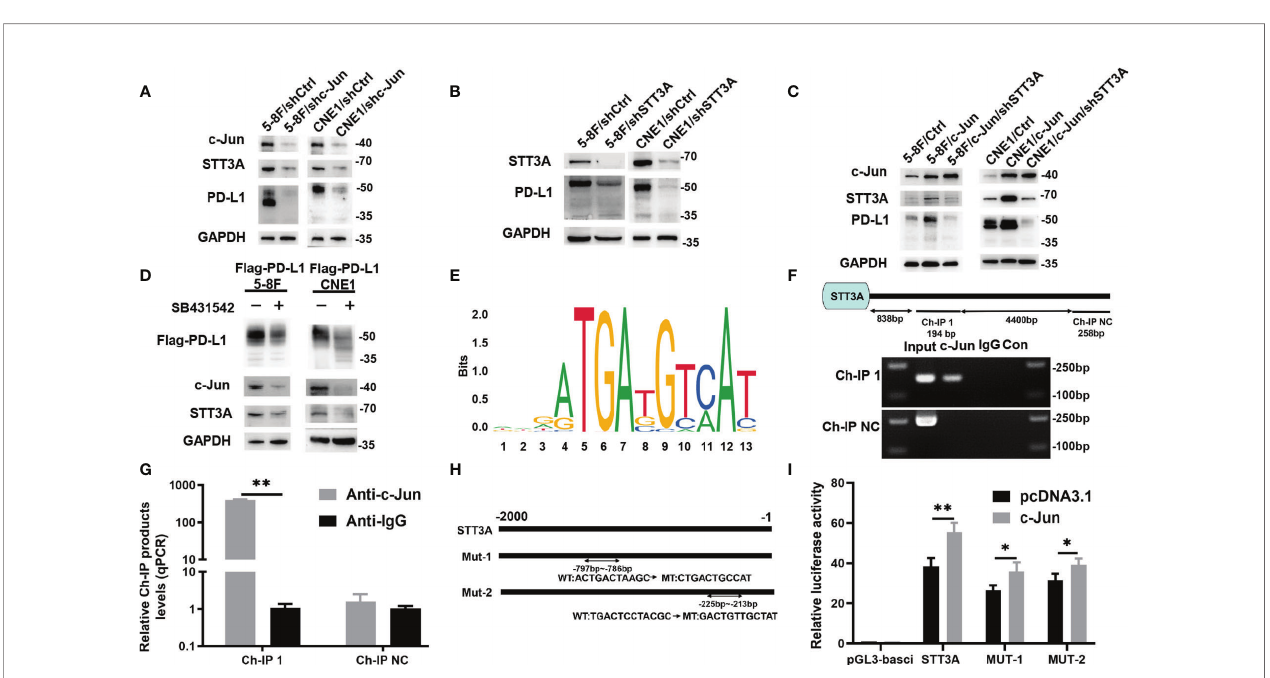
FIGURE 3 | SB431542 Downregulated Glycosylation of PD-L1 via C-Jun/STT3A Pathway in Vitro and C-Jun was a Direct Transcriptional Regulator of STT3A. (A) Western blot analysis of c-Jun, STT3A and PD-L1 after silencing c-Jun in 5-8F and CNE1 cells. (B) Western blot analysis of STT3A and PD-L1 after silencing STT3A in 5-8F and CNE1 cells. (C) Western blot analysis of c-Jun, STT3A and PD-L1 after overexpressing c-Jun with(out) silencing STT3A in 5-8F and CNE1 cells. (D) Western blot analysis of PD-L1, c-Jun and STT3A in exogenous Flag-PD-L1 expressing 5-8F and CNE1 cells with the treatment of 20 m M SB431542. (E) The binding motif of c-Jun from JASPAR database. (F) The CHIP-PCR assay was used to assess the binding of STT3A promoter region. (G) Anti-c-Jun-pulled down chromatins were analyzed by qRT-PCR. (H) A diagram showing the relationship of full-length and mutant STT3A promoters. (I) Dual-luciferase reporter gene assay was performed to indicate the interaction between c-Jun and STT3A. Bars, mean ± SD, * p <0.5, ** p